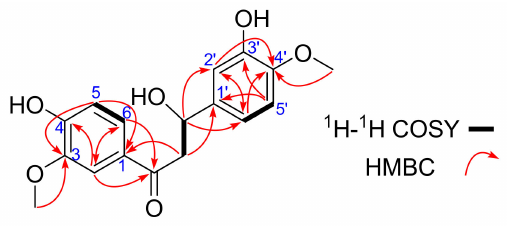
Figure 1. 1 H- 1 H COSY and HMBC correlations of 1 .